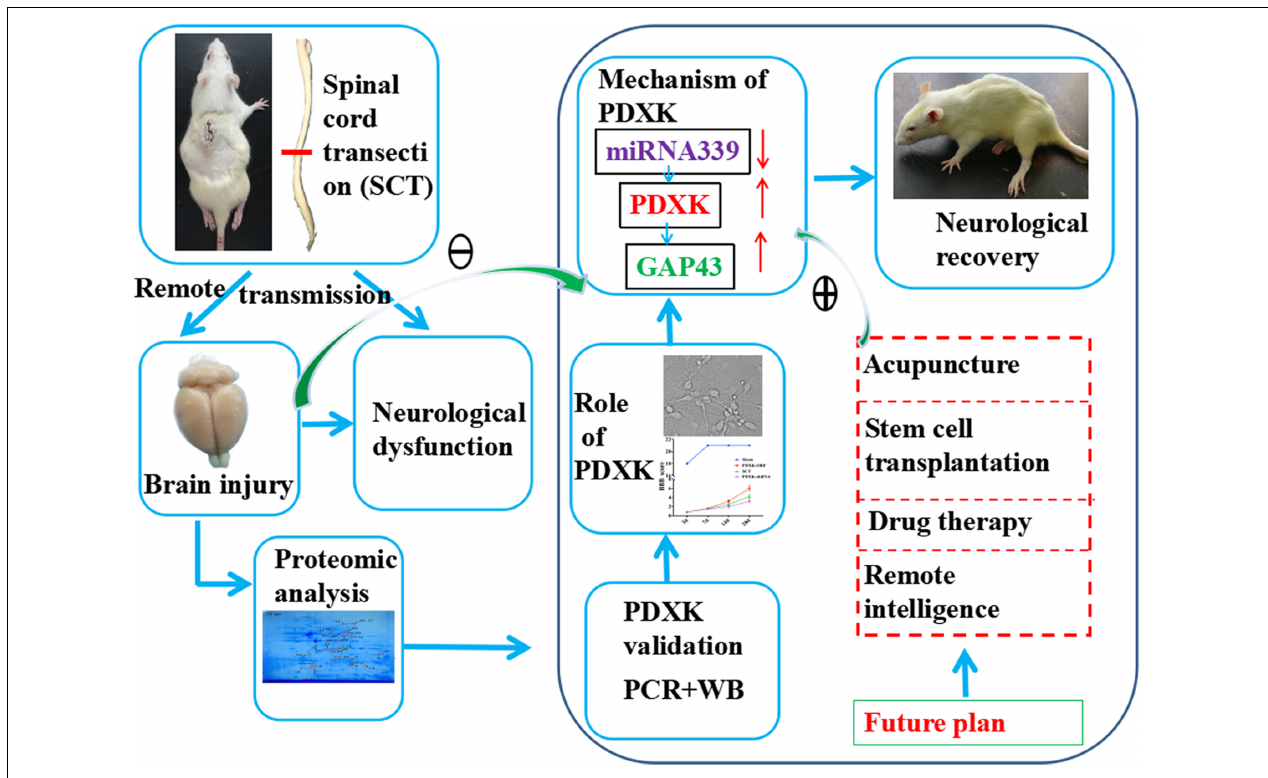
FIGURE 7 | The underlying mechanism that how PDXK promoted neurological recovery of SCT rats. First, the SCT model was successfully established, and the brain injury and neurological dysfunction were observed. By 2D electrophoresis and MALDI-TOF-MS, we found that PDXK was downregulated at 3 days and upregulated at 14 and 28 days after SCT. Then, it was confirmed that PDXK was expressed in cortical neurons via double immunofluorescent labeling, which indicated that PDXK may exert a crucial role in functional recovery in SCT rats. Next, it was confirmed that the BBB score and the neurons were all significantly increased under the treatment of PDXK-ORF. Afterward, the prediction of “miRwalk,” “miRDB,” “miRanda,” and “TargetScan” revealed that PDXK was a target gene of miR-339; meanwhile, it was pointed that PDXK was specifically regulated by miR-339. Through inhibiting the expression of miR-339, it was affirmed that the cell size, the number of neurons, and the axon length were all increased. Finally, the GAP43 was screened out as the mechanism pathway by gene MANIA. For the future plan, the treatment of acupuncture, stem cell transplantation, drug therapy, and remote intelligence may perform to downregulate the expression of miR-339 and upregulate the expression of PDXK and GAP43 to promote neurological recovery. SCT, spinal cord transection; GAP43, growth associated protein-43; BBB, Basso, Beattie, and Bresnehan.